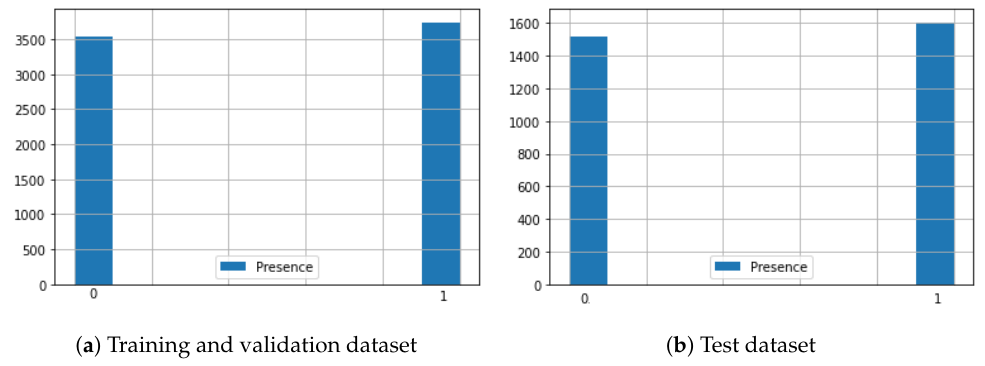
Figure 7. Histograms of the “Presence” values of the samples, showing the balance between the Presence and Non-Presence samples in the Training ( a ) and Test ( b )